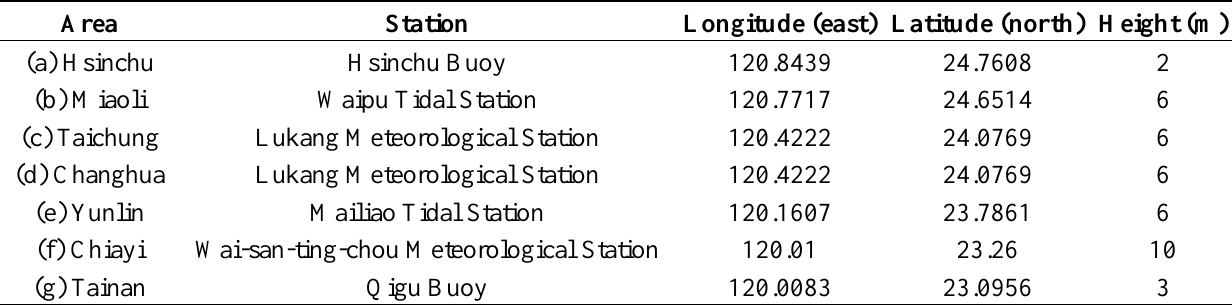
Table 2. Data from long-term observations on the west coast of